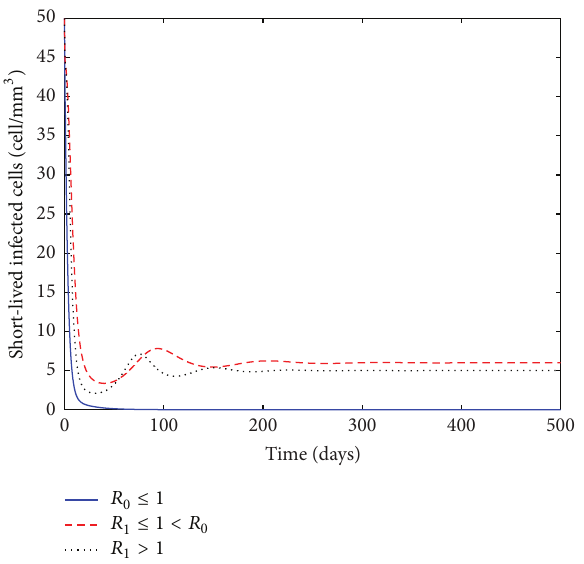
Figure 3: The evolution of chronically infected cells for model (2)– (6).